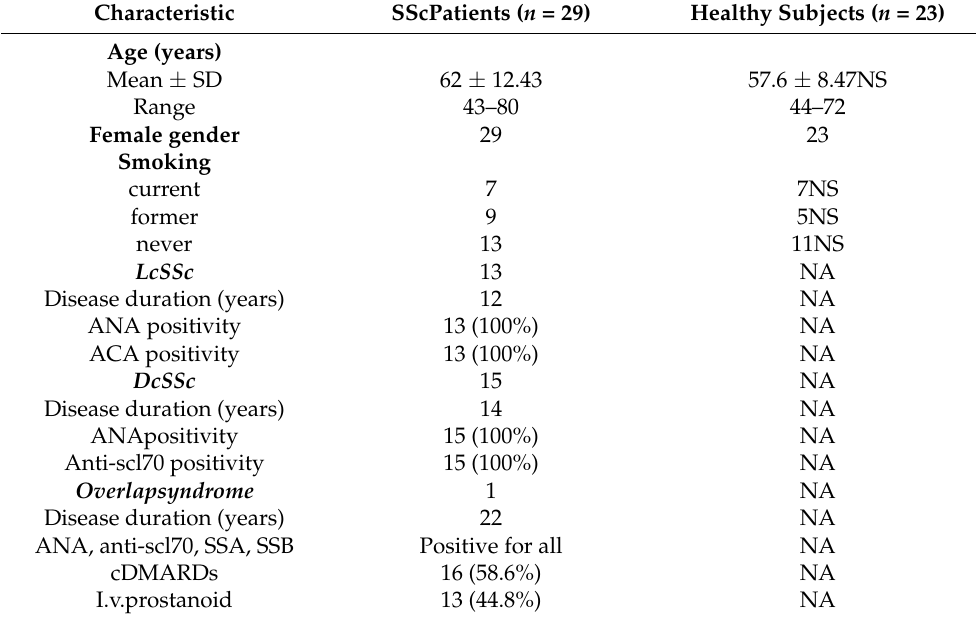
Table 2. Demographic, lifestyle and clinical characteristics of study